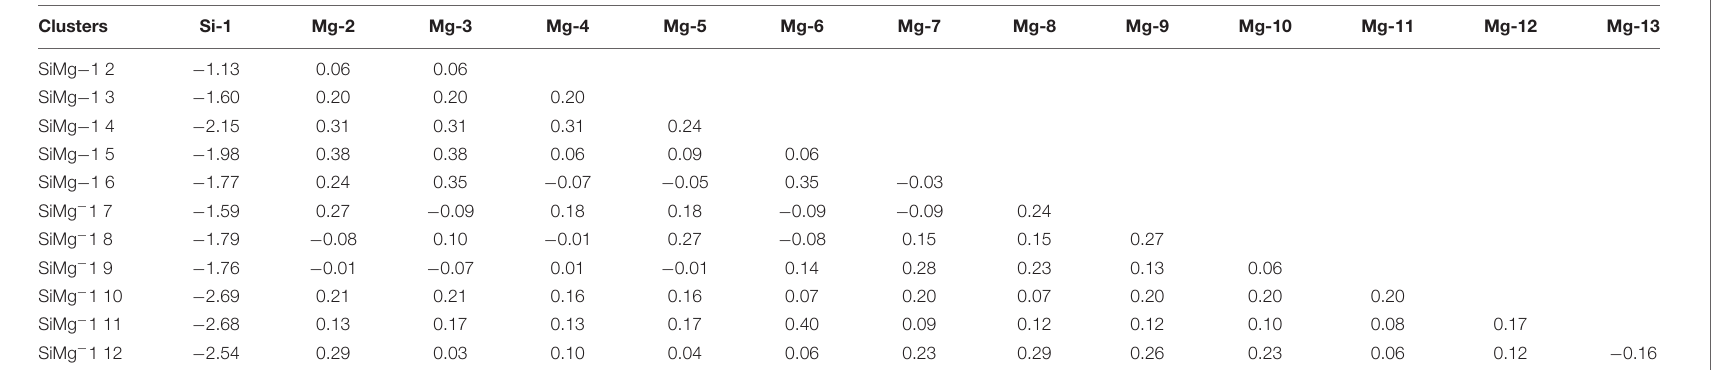
TABLE 3 | NCP of the ground state of SiMgn + 1 n ( n = 2–12) clusters. Clusters